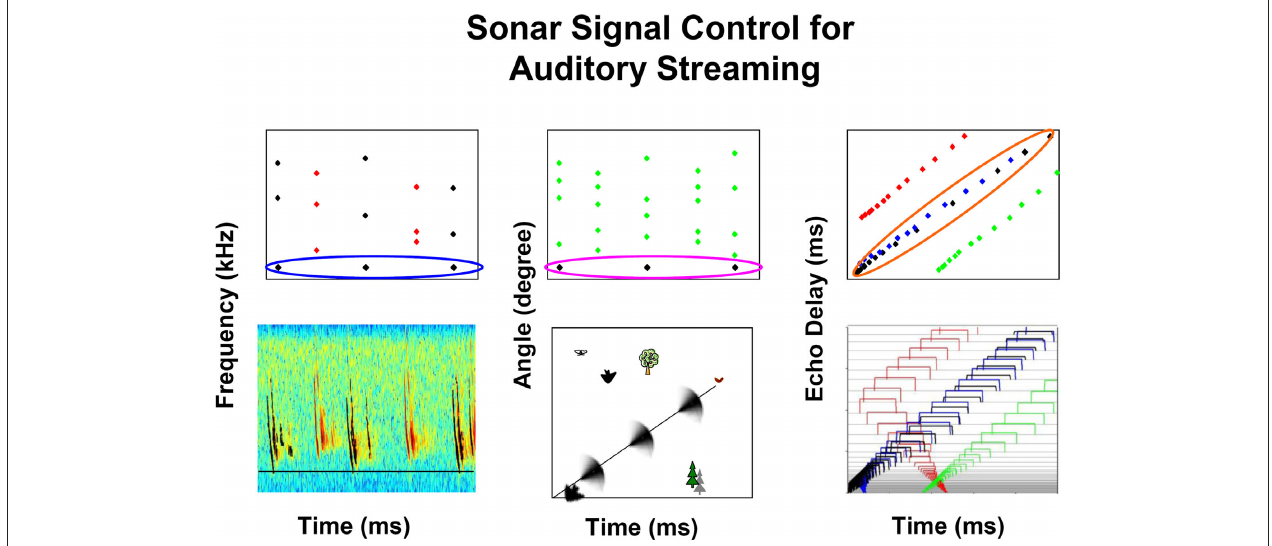
Figure 8 | Schematic illustrating the active adjustments that bats make in call frequency (A), beam aim (B) and signal duration (C) that can aide in the segregation and streaming of acoustic information along the perceptual dimensions of pitch, direction, and